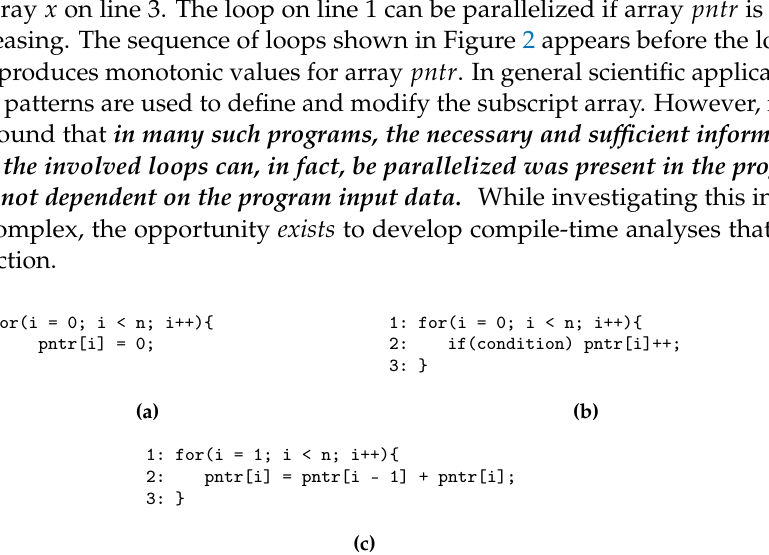
Table 1: Benchmarks codes analyzed for the presence of subscripted subscripts.